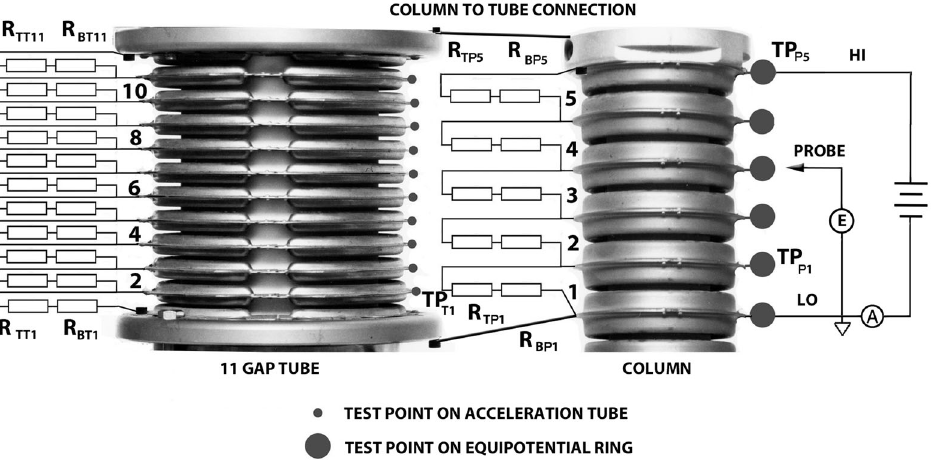
FIG. 5. The constant voltage method for noninvasive diagnostics of the high-voltage grading system of an electrostatic accelerator. The 11 gap acceleration tube and the 5 gaps of the top section of the column post are shown. There is a pair of 40 kV, 112 mm-long Welwyn resistors for each post gap shown as top and bottom resistor R employ pairs of 20 kV, 61 mm-long 300 M Ω resistors shown as top and bottom resistors R shown next to the tube and post are the insulating gap numbers. E is the electrometer and A is the second electrometer or